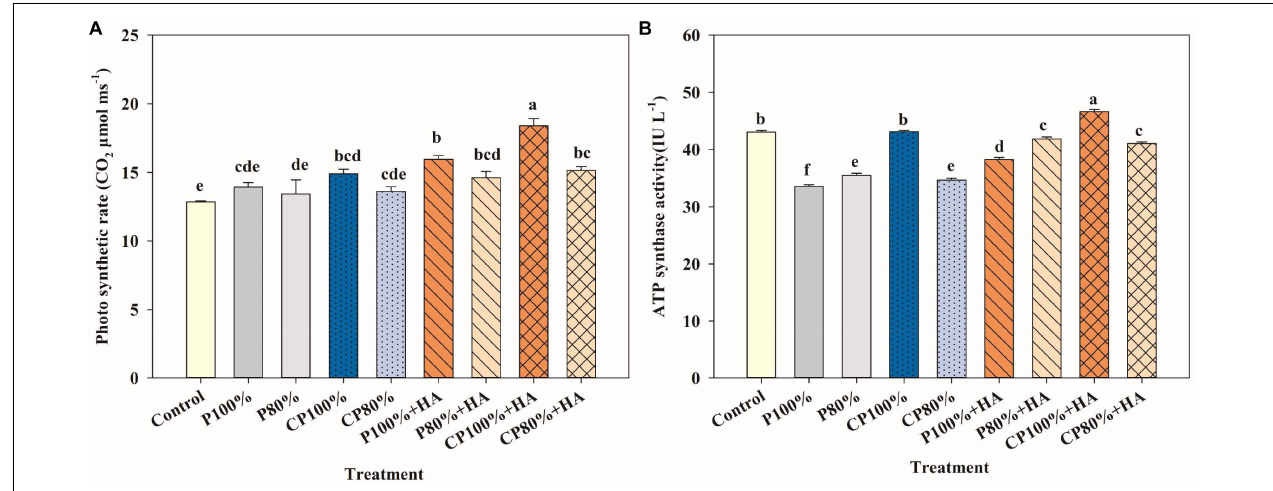
FIGURE 6 | Photosynthetic rate (A) and ATP synthase activity (B) of maize in different fertilization treatments at the twelve-leaf stage. Control, no P fertilizer added; P 100%, diammonium phosphate (DAP) at 75 kg P 2 O 5 ha − 1 ; P80%, DAP at 60 kg P 2 O 5 ha − 1 ; CP 100%, coated DAP (CDAP) at 75 kg P 2 O 5 ha − 1 ; CP 80%, CDAP at 60 kg P 2 O 5 ha − 1 ; P 100% + HA, DAP at 75 kg P 2 O 5 ha − 1 and combined with humic acid (HA); P 80% + HA, DAP at 60 kg P 2 O 5 ha − 1 and combined with HA; CP 100% + HA, CDAP at 75 kg P 2 O 5 ha − 1 and combined with HA; CP 80% + HA, CDAP at 60 kg P 2 O 5 ha − 1 and combined with HA. Different letters above the bars indicate significant differences at P < 0.05 followed by Duncan’s multiple range